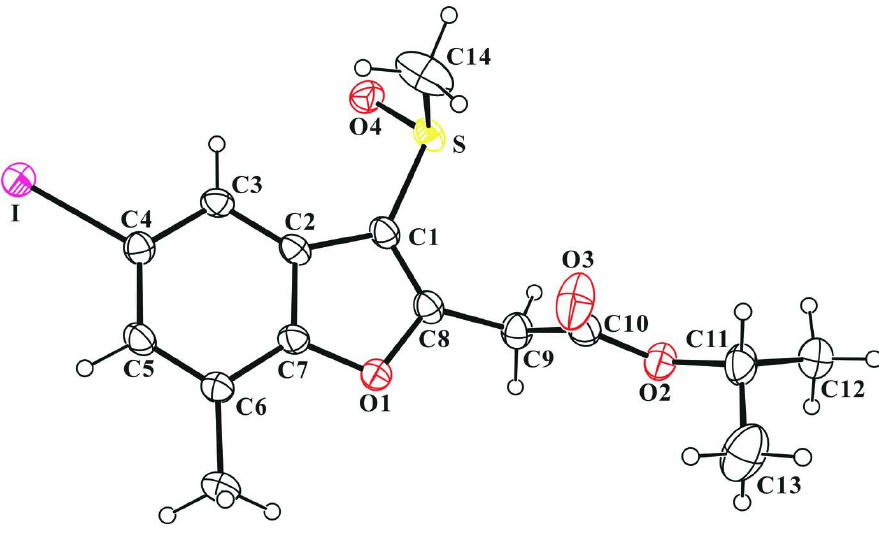
Figure 1 The molecular structure of the title compound, showing displacement ellipsoids drawn at the 30% probability level.